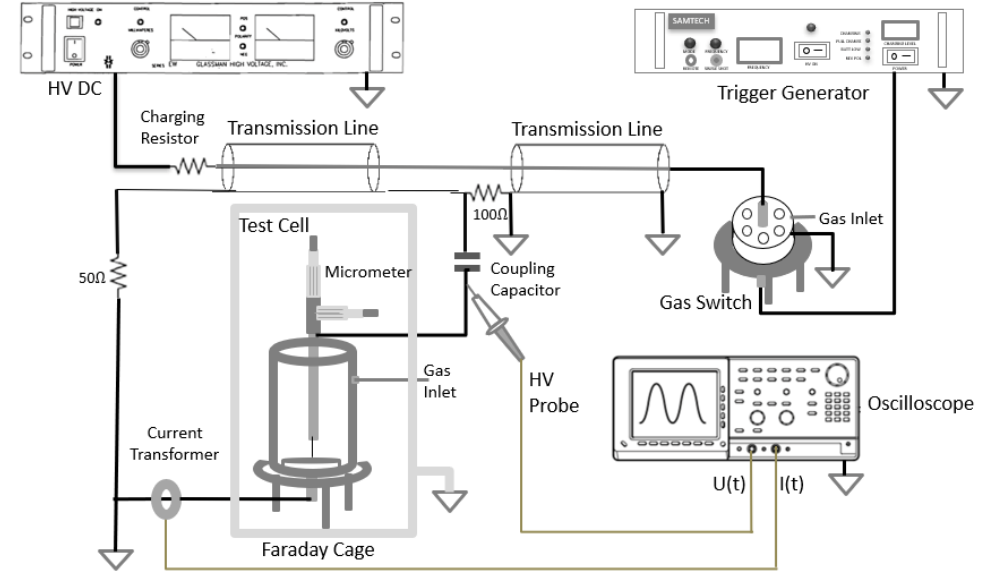
Figure 2. Experimental arrangement, incorporating Blumlein-based HV pulse generator, test cell and diagnostic devices.